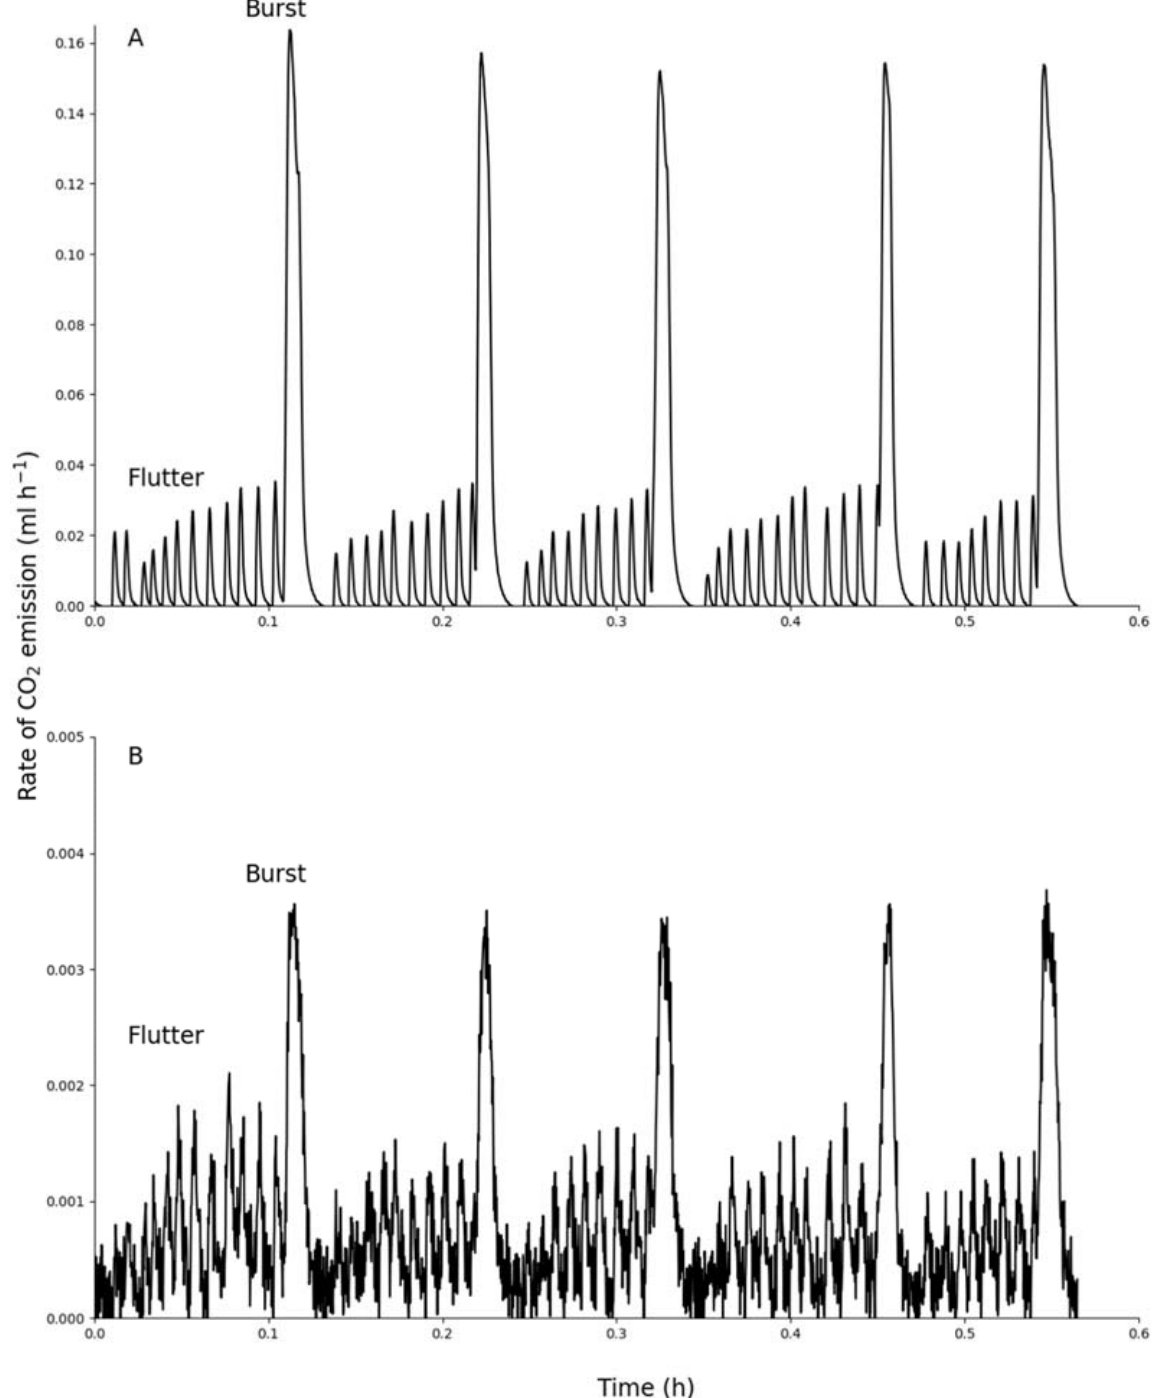
Figure 2. Recording of CO 2 emission from the mesothoracic spiracles ( A ) and elytral case ( B ) simultaneously in Z. amabilis (mass = 0.16 g).